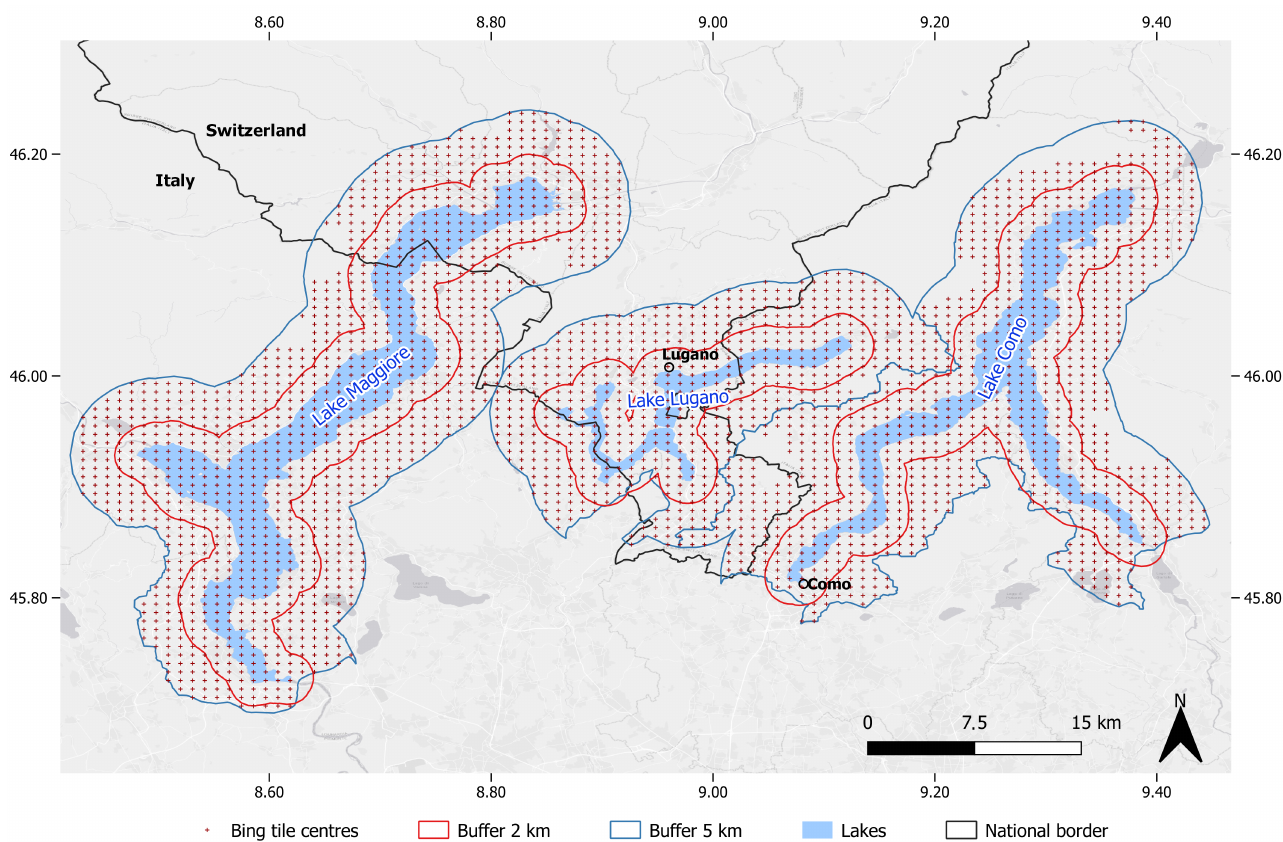
Figure 1. Study areas (red and blue outlined polygons), Insubric lakes (from left to right: Lake Maggiore, Lake Lugano and Lake Como) and Bing tile grid centres (red dots) for the considered Facebook Population Maps collection. Como and Lugano are the most populated urban centres of the study region. CRS: WGS84. Basemap data: Esri Gray (light)